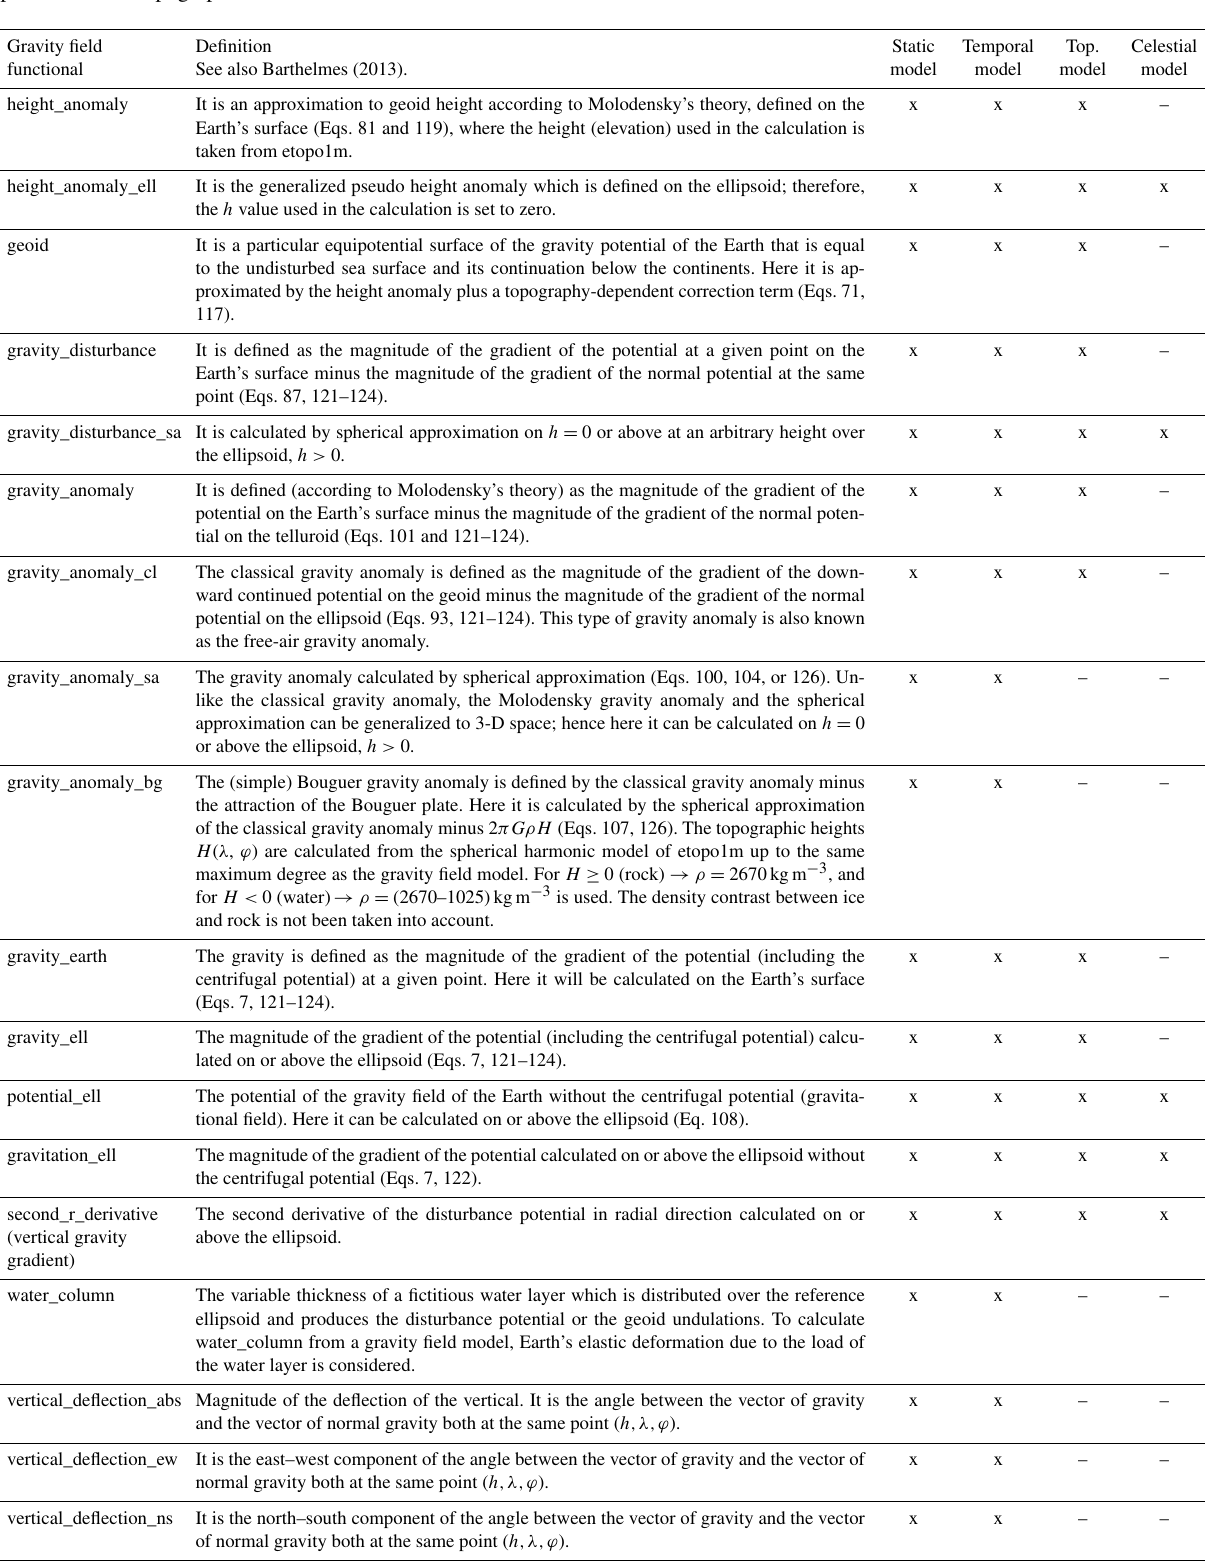
Table 2. The list of gravity field functionals available on the calculation service for grid and point calculations. The detailed description and definitions of the gravity field functionals are given in detail in Barthelmes (2013). The equation numbers (Eqs.) refer to the same document. Top. model is the topographic